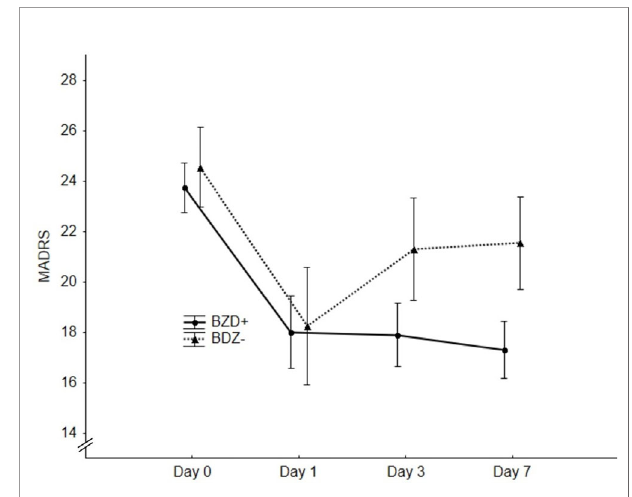
FIGURE 1 | Receiver operating characteristic (ROC) analysis distinguishing responders and nonresponders (AUC=0.91, 95%CI 0.68 – 0.99, p < 0.001).